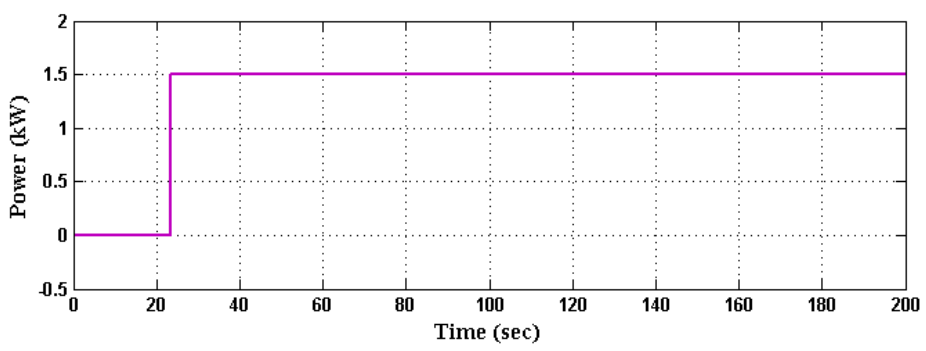
Figure 13. Output power to the grid.